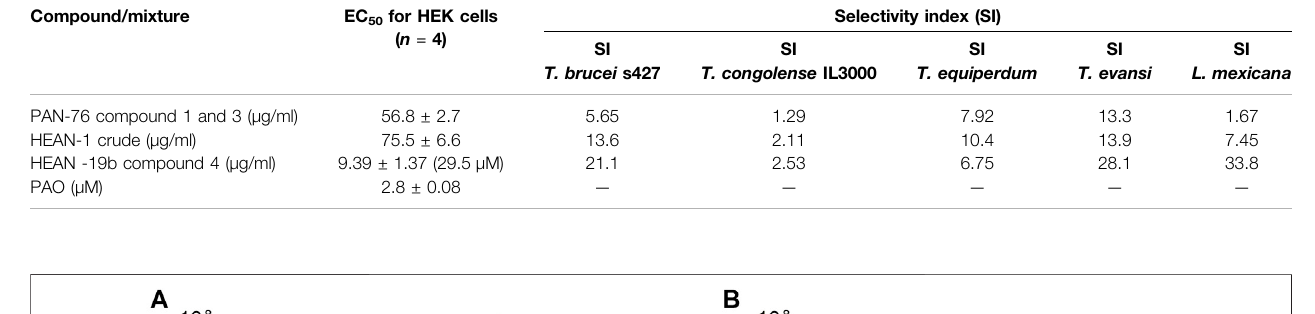
Frontiers in Chemistry |